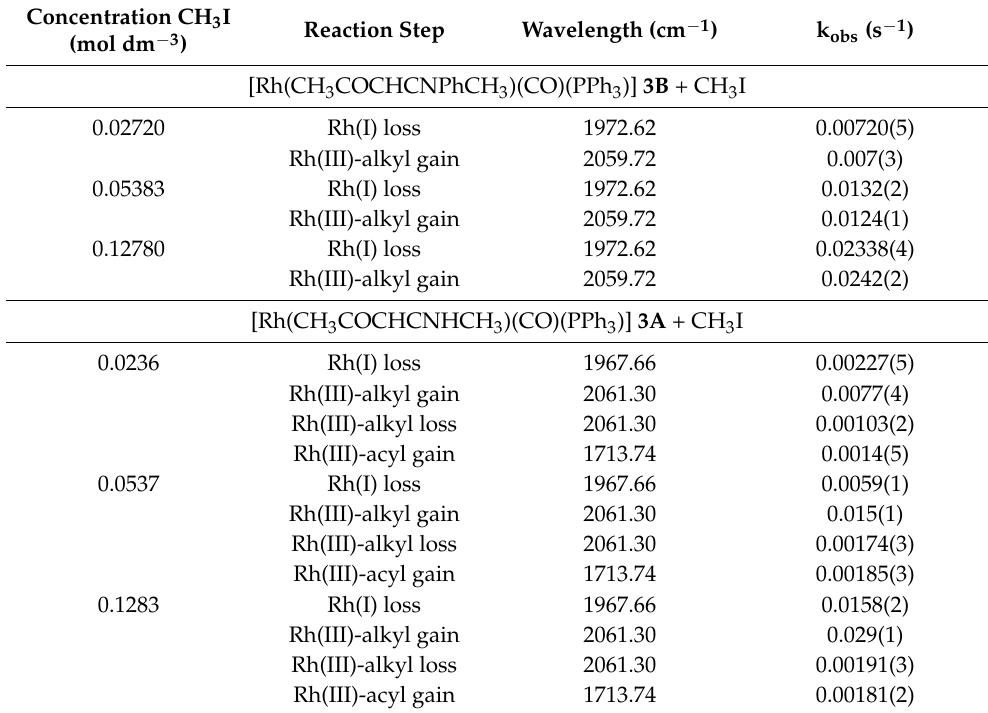
Table 3. Observed kinetic rate constants, wavelengths, and concentrations utilized in the IR study of the oxidative addition reaction between the indicated [Rh(N,O-BID)(CO)(PPh 3 )] and CH 3 I at 25 ◦ C. Concentration CH 3 I Reaction Step Wavelength (cm − 1 (mol dm − 3 )